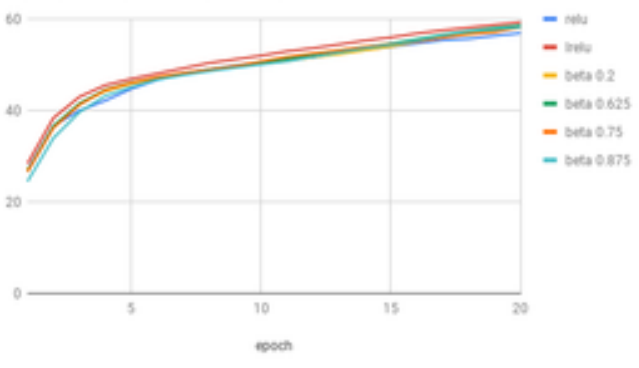
Figure 3. Visualisation of optimisation and regularisation of Capsnets on CIFAR-10 dataset Table 3. Comparison between ReLU, LReLU and e-Swish with reference to loss parameter